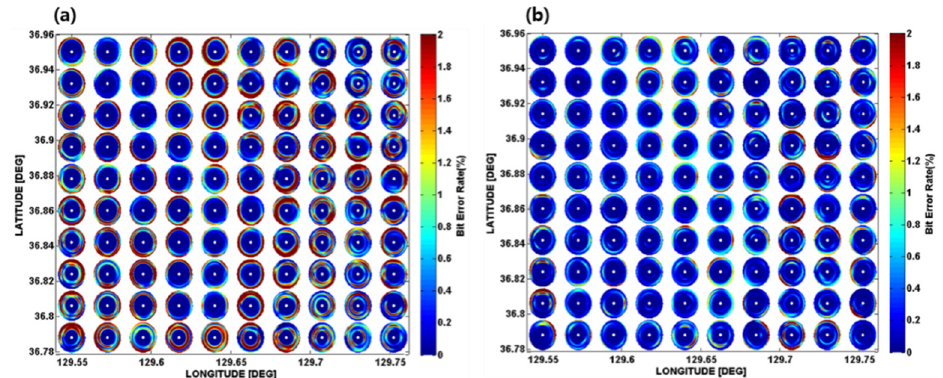
Figure 4. BER performance field for 100 grid points predicted for ( a ) the three-channel pressure sensor array, and ( b ) the single-vector sensor in the targeted area in February.